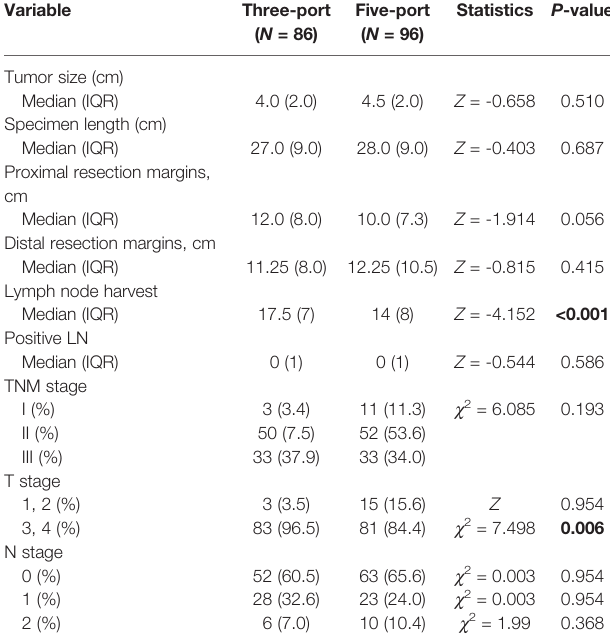
TABLE 3 | Pathologic and oncologic outcomes.